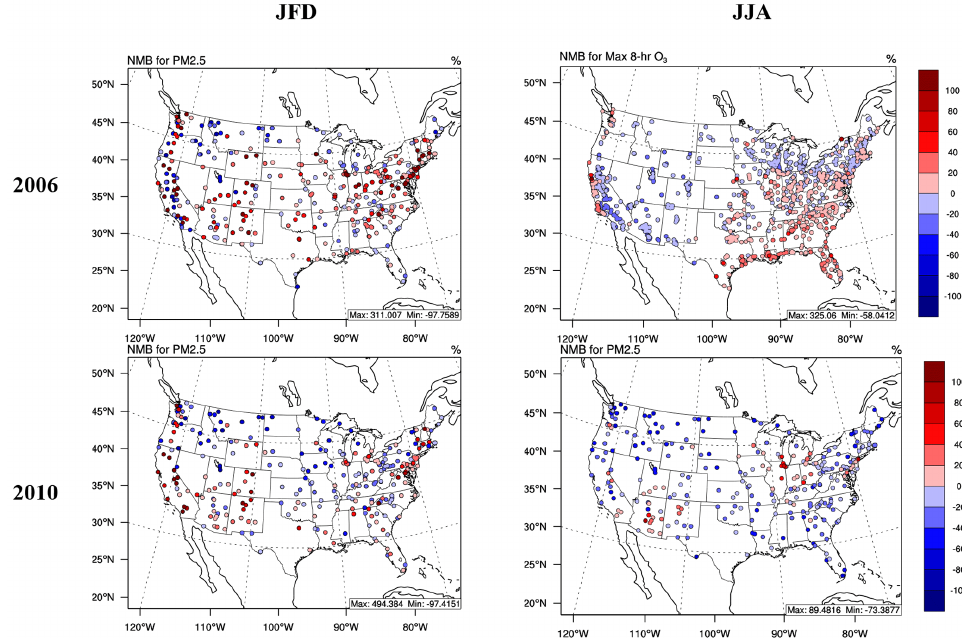
Figure 5. Spatial Distribution of NMB plots for JFD and JJA 2006 and 2010 for average 24h PM 2 . 5 concentrations based on evaluation against the IMPROVE, STN and SEARCH sites.